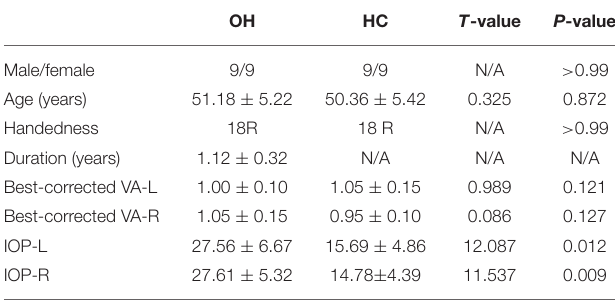
TABLE 2 | Demographics and behavioral results of OH and HCs